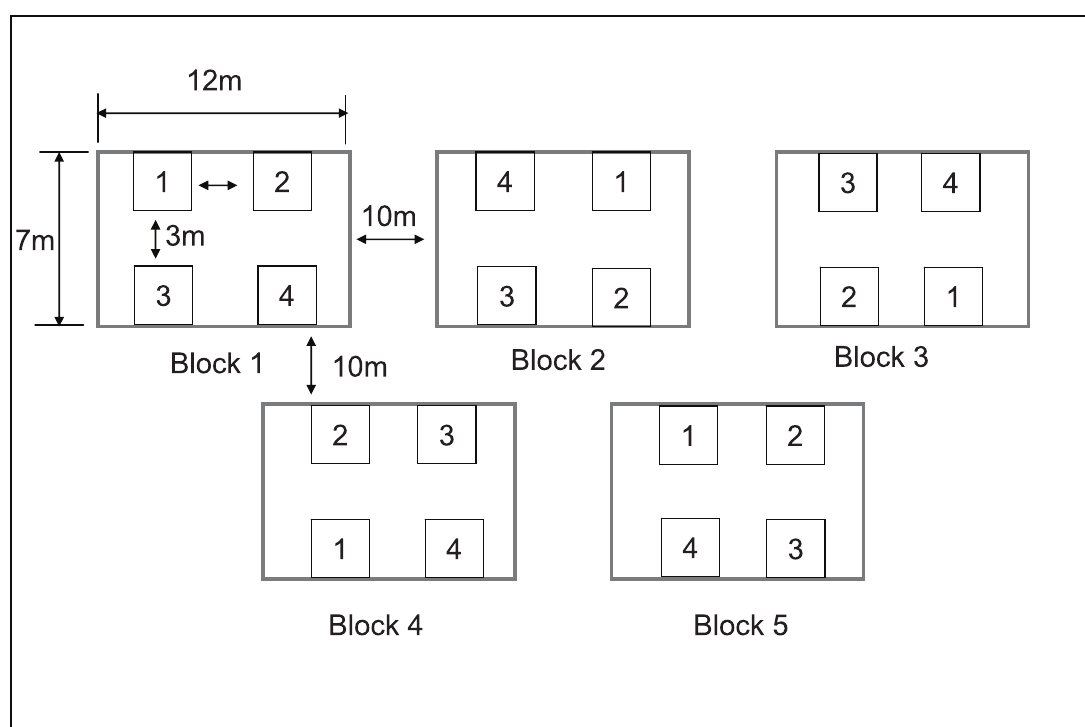
Figure 1. Design of the field study. ( A ) The four different cage treatments, i.e. natural enemy exclusion degree, in the field study; Exclusion cages: prevented natural enemy (predators and aphid parasitoids) movement, Restriction cage: prevented predator movement but allowed aphid parasitoids to colonize the plants, Sham cage and No cage: allowed free access to the plants for all natural enemies. ( B ) Within- and among block design: the distance among treatments within a block was 3 m, and among blocks was 10 m. The experimental cotton field was 70 m 6 30 m. doi:10.1371/journal.pone.0102980.g001 PLOS ONE | www.plosone.org 3 August 2014 | Volume 9 | Issue 8 |